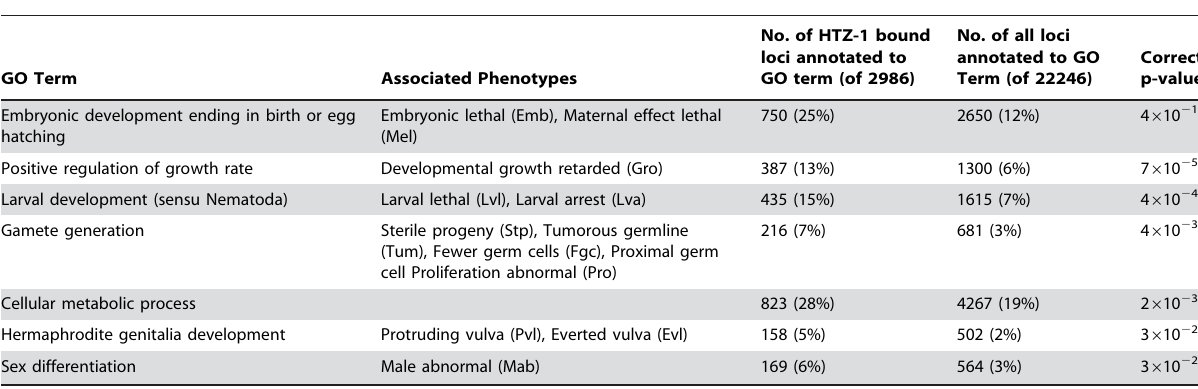
Table 1. HTZ-1 is enriched at genes essential for growth and